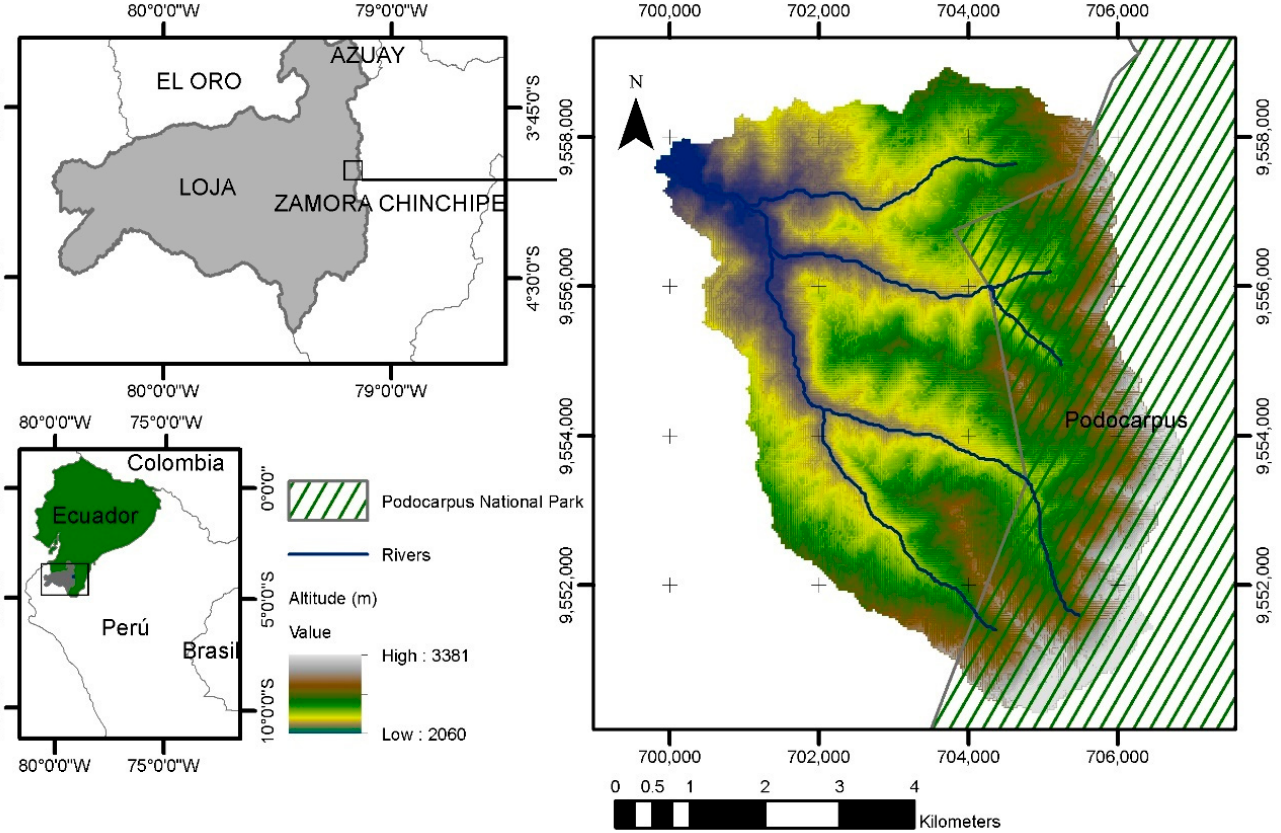
Figure 1. Location map of ZH basin.